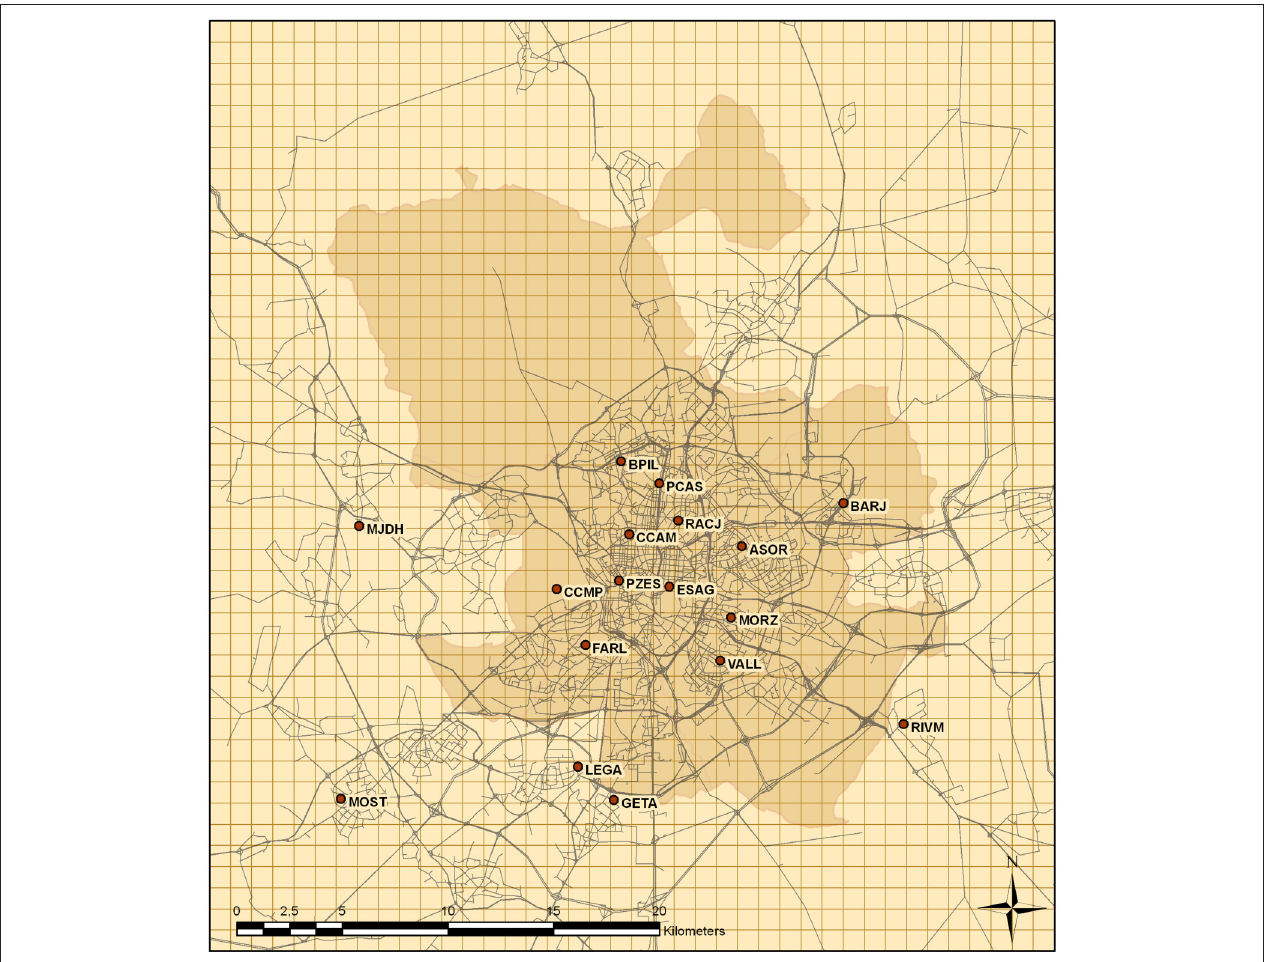
FIGURE 1 | CMAQ modeling domain for Madrid area and air quality monitoring stations selected to evaluate the resuspension